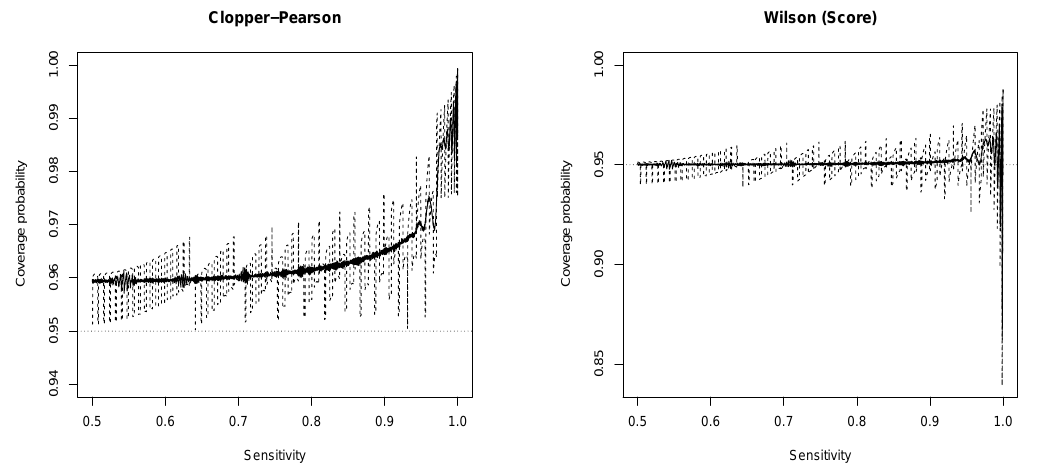
Figure 1. Coverage probability of sensitivity intervals varying with the sensitivity, for η = 0.25 and n = 500, obtained with the new formula (solid line) and the conventional formula (dashed line), for Clopper–Pearson (left) and Wilson (right). The horizontal spotted line marks the nominal confidence level,